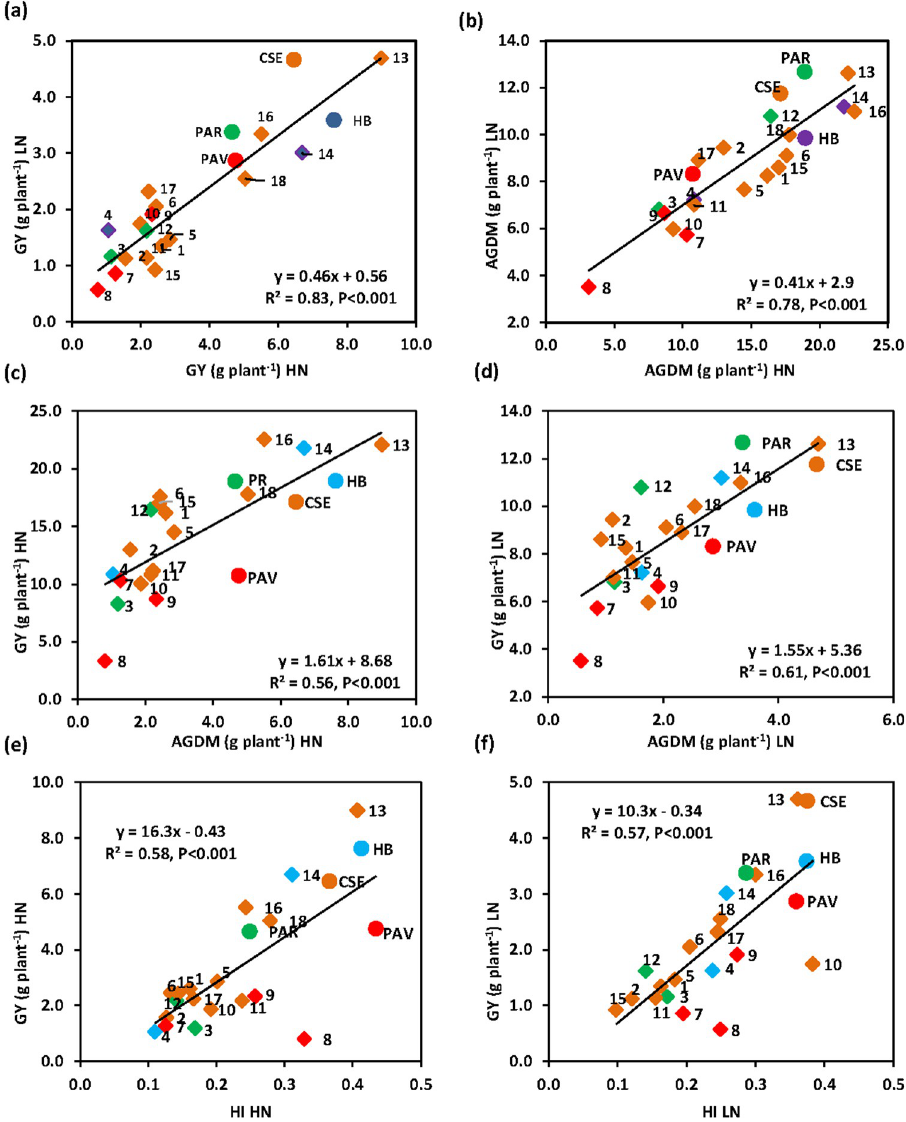
Fig 1. Linear regression of (a) grain yield plant -1 (GY, 100% DM) under high N (HN) versus low N (LN), (b) above- ground dry matter plant -1 (AGDM, 100%) under HN versus LN, (c) GY versus AGDM under HN, (d) GY versus AGDM under LN, (e) GY versus harvest index (HI) under HN and (f) GY versus HI under LN in 22 genotypes (diagonals: 18 amphidiploid lines and circles: 4 bread wheat parents, same colour used for bread wheat parent and respective amphidiploids) (mean 2015 and 2016). CSE Chinese Spring; HB Highbury; PAR Paragon; PAV Pavon 76. For amphidiploid line codes, see Table 1.